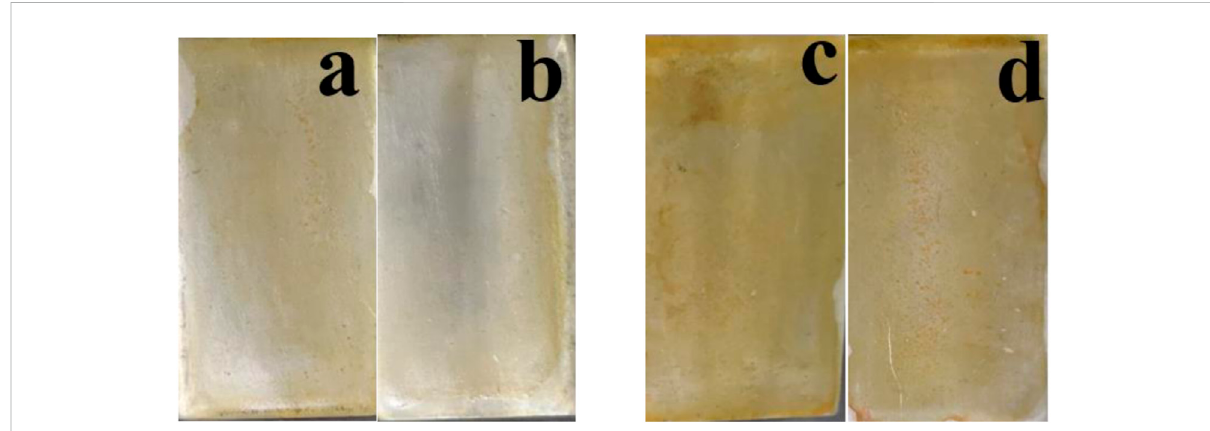
FIGURE 3 SEM images of the Ce-based conversion coating on the Al alloy 6101 before the corrosion test showing (A) homogenous coating on the substrate and (B) enrichment of the coating, as well as (C) EDS elemental analysis.